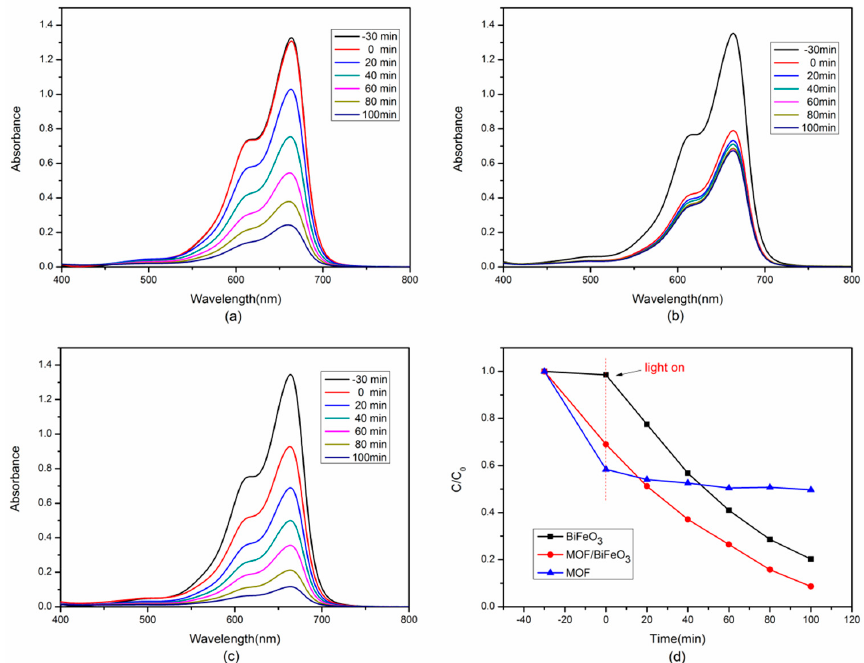
Figure 5. Time dependent UV–vis spectrum changes of MB catalyzed by ( a ) pure BiFeO 3 ; ( b ) pure MOF; and ( c ) MOF/BiFeO 3 composite; ( d ) The photocatalytic degradation efficiencies of all samples to degrade MB.